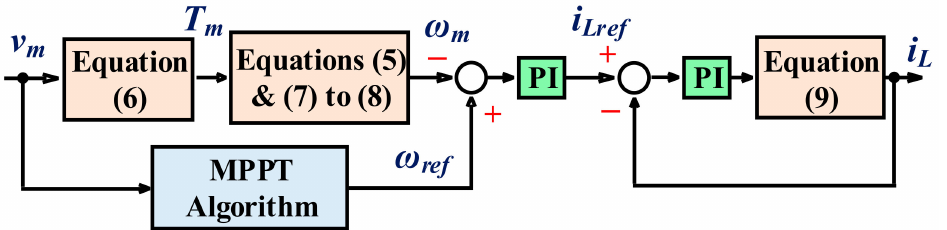
Figure 3. Block diagram of speed control of Permeant Magnet Synchronous Generator (PMSG) connected to wind/tidal